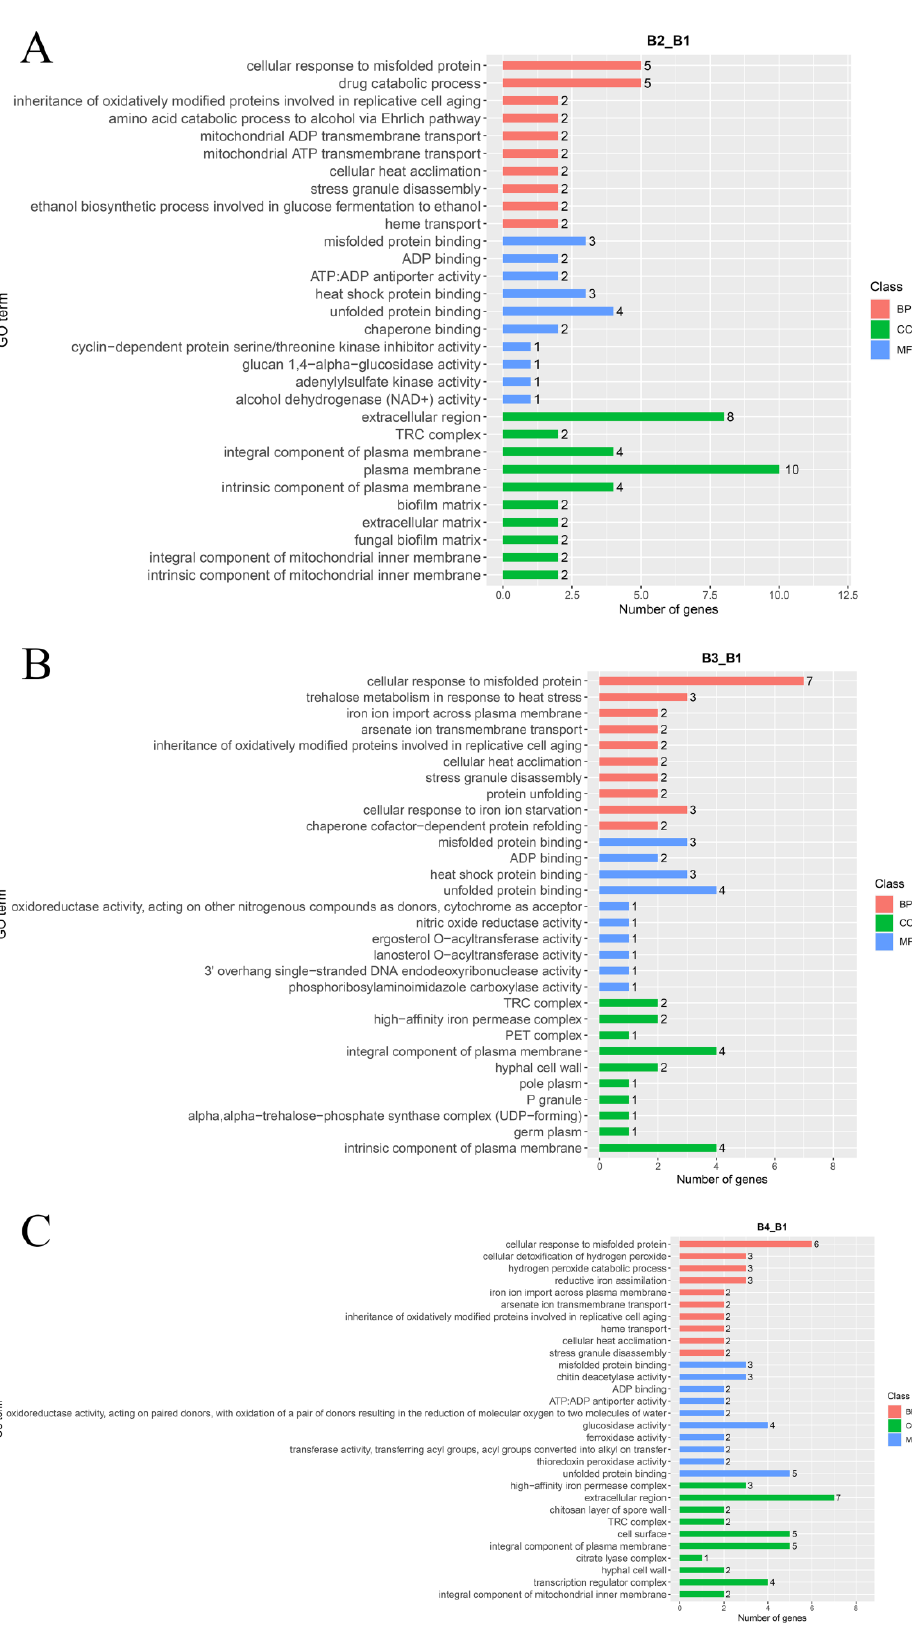
Figure 6. GO classification maps of DEGs of the ( A ) B2 vs. B1 (B2_B1), ( B ) B3 vs. B1 (B3_B1), and ( C ) B4 vs. B1 (B4_B1) comparisons.